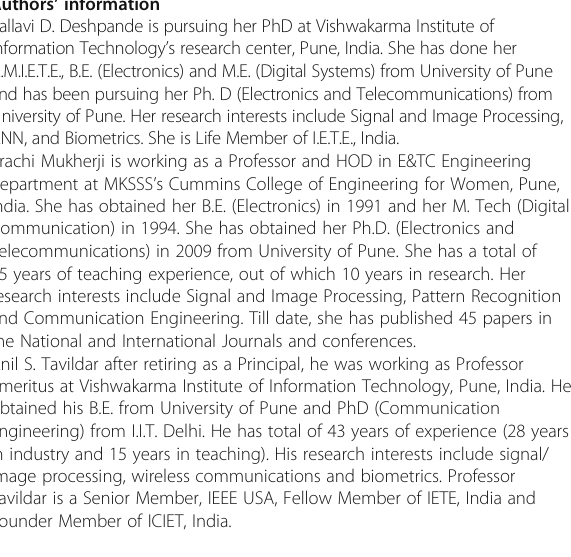
Combined approximate plus horizontal DWT coefficients using optimum weights